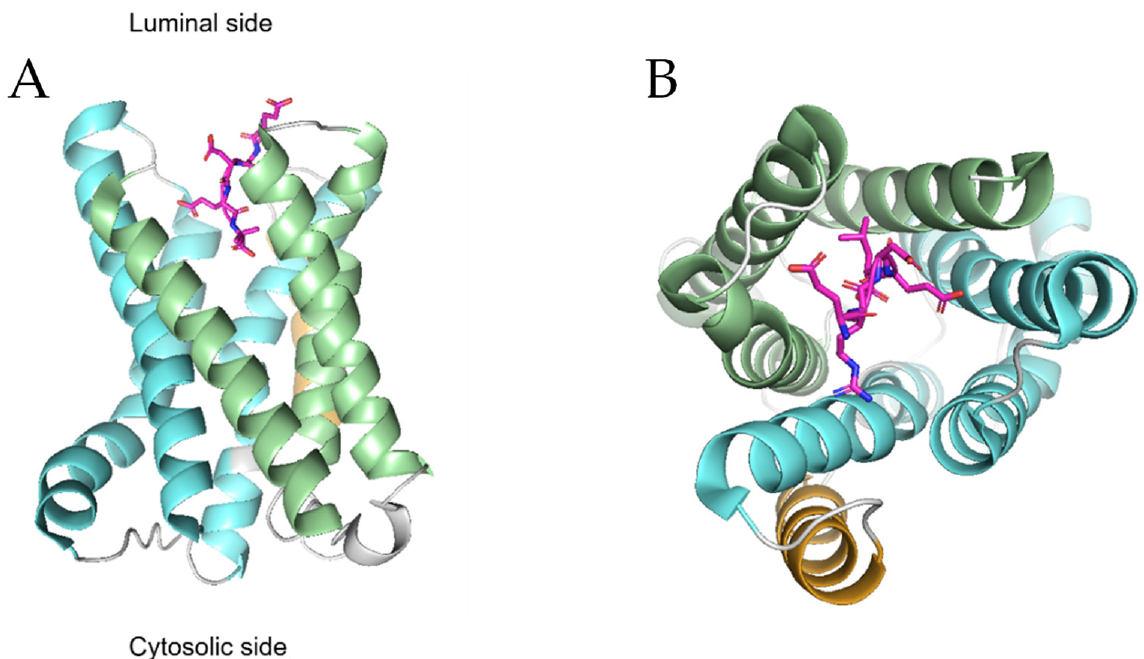
Figure 3. Structural organization of KDELR. The images show the side ( A ) and top view ( B ) of Gallus gallus KDELR2 according to the PDB database coordinates (PDB DOI: 10.2210/pdb6ZXR/pdb 27 April 2022). The two helical bundles made up of the first three and last three helices are shown in light green and light blue, respectively. The fourth transmembrane helix, which connects the two bundles, is shown in light brown. The RDEL ligand, represented in sticks, is located in the pocket formed by the TM1-3 and TM5-7 helices.